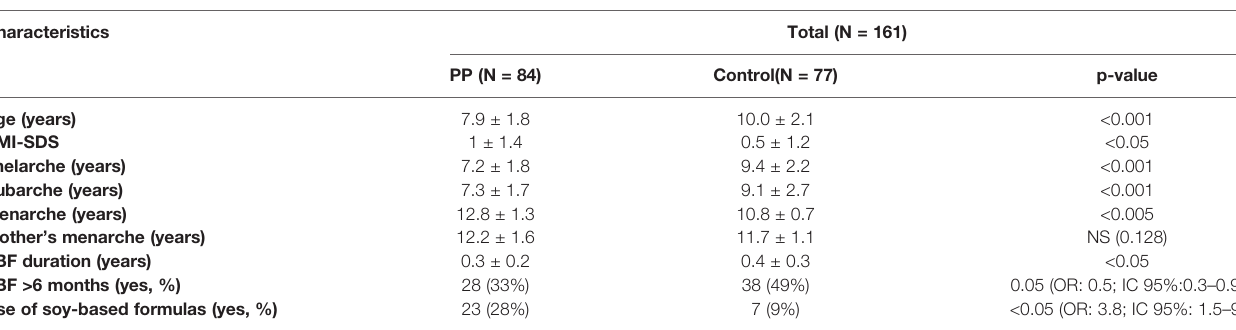
TABLE 1 | Clinical characteristics and risk factors.